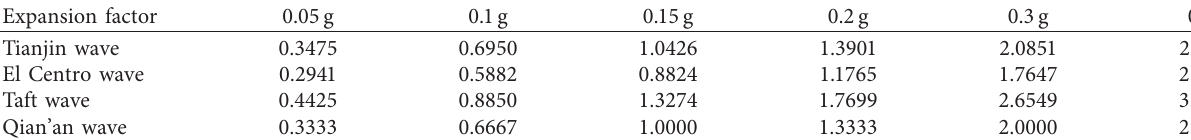
Table 8: Expansion factors of the seismic wave intensities.